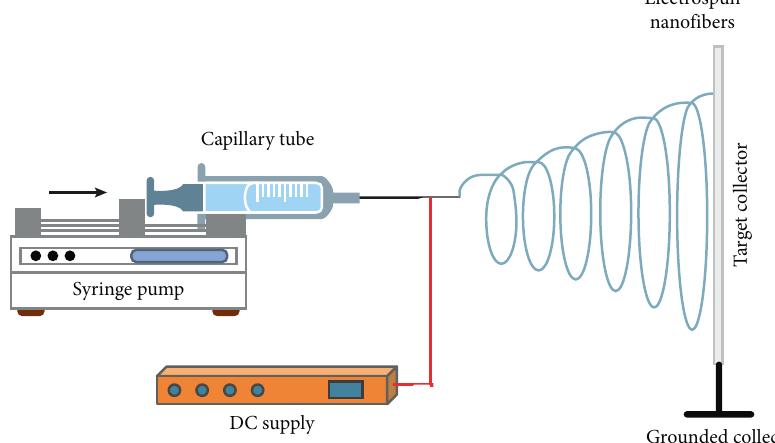
Figure 2: Electrospinning